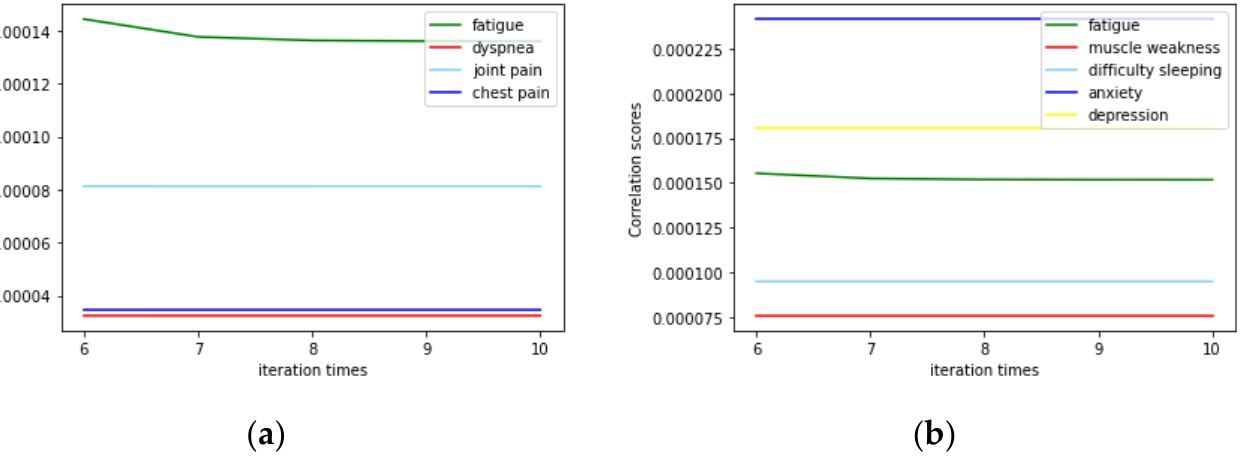
Figure 5. ( a ) Correlation scores between COVID-19 and long-COVID symptoms in Europe. ( b ) Cor-